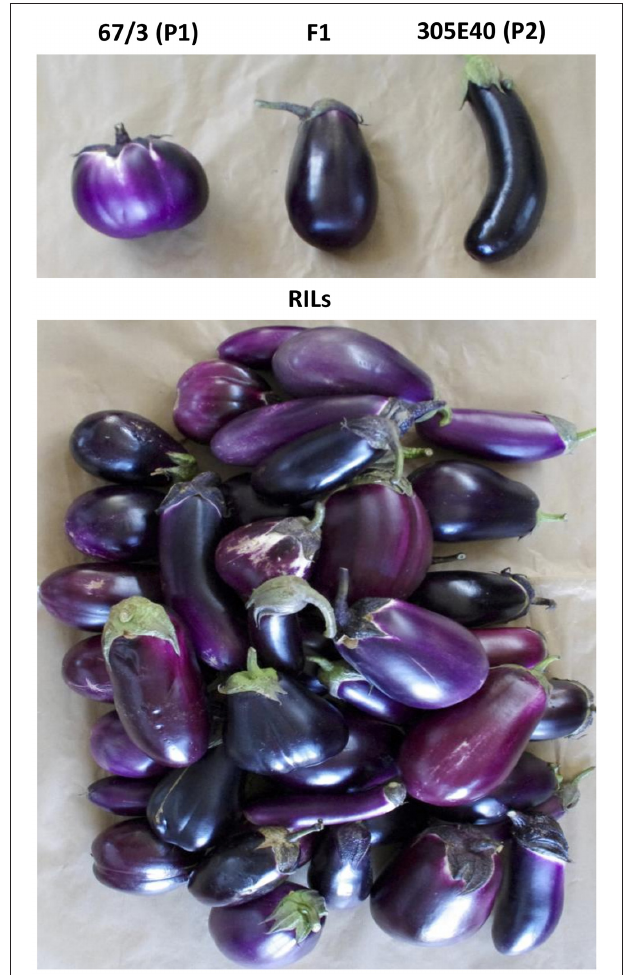
FIGURE 1 | Phenotypes of fruits at commercial maturation. Top: the two parents “67/3” (P1, male) and “305E40” (P2, female) of the RIL population, and the F1 hybrid. Bottom: the F6